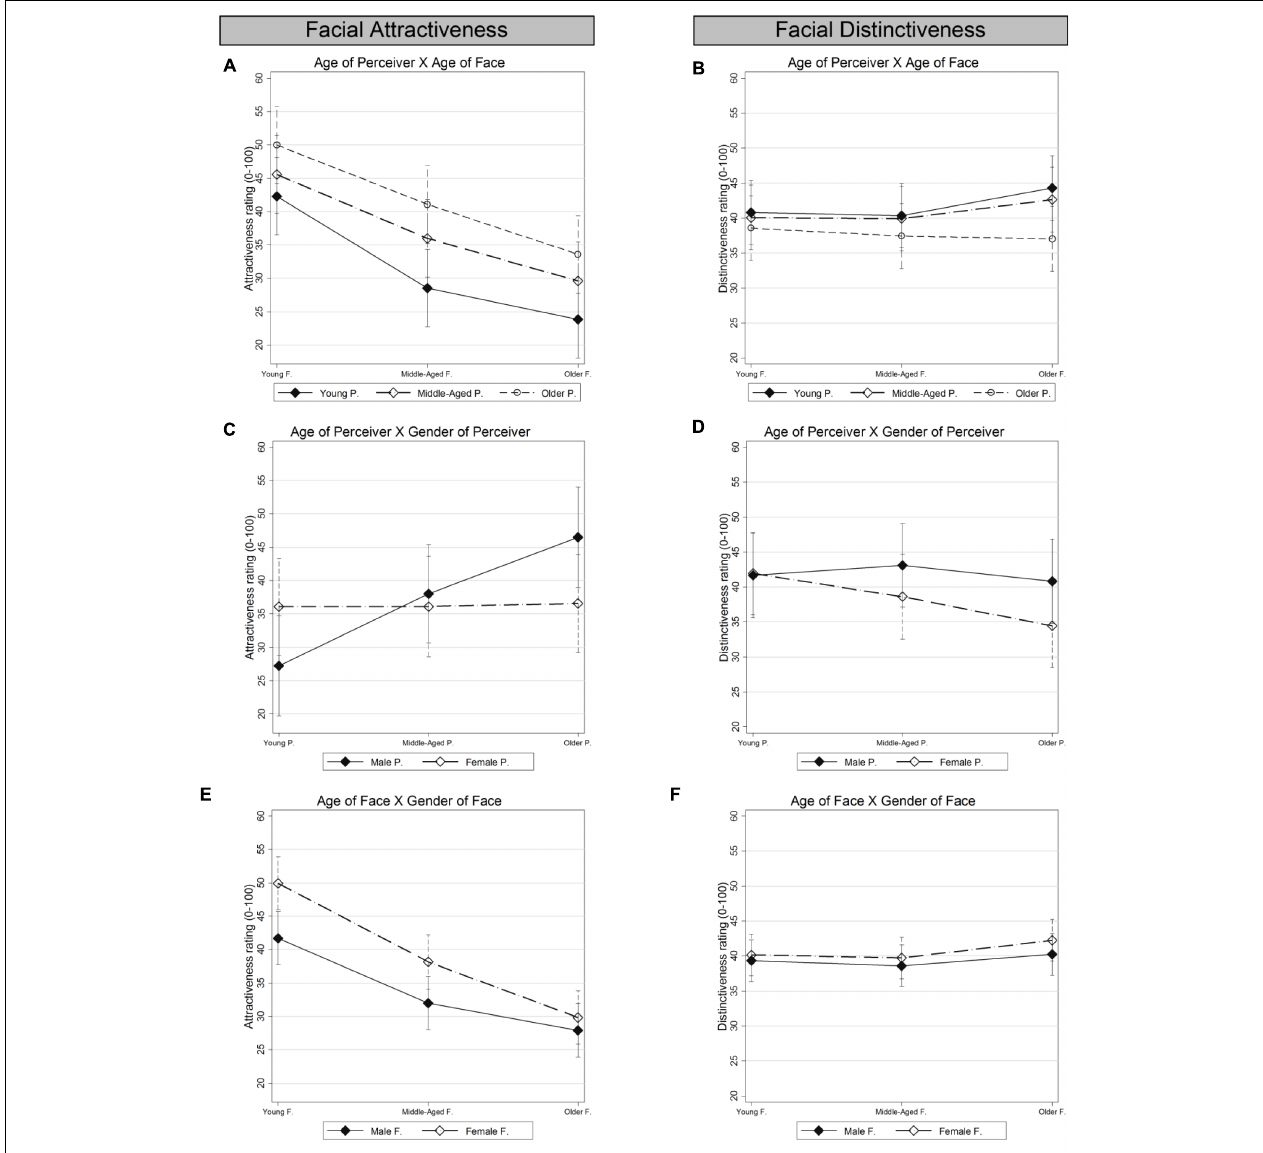
FIGURE 2 | Predicted marginal means for attractiveness and distinctiveness for specified two-way interactions pertaining to age and gender: (A) Age of Perceiver × Age of Face, for attractiveness. (B) Age of Perceiver × Age of Face, for distinctiveness. (C) Age of Perceiver × Gender of Perceiver, for attractiveness. (D) Age of Perceiver × Gender of Perceiver, for distinctiveness. (E) Age of Face × Gender of Face, for attractiveness. (F) Age of Face × Gender of Face, for distinctiveness. Error bars indicate 95% confidence intervals for the point predictions, corrected for multiple comparisons (Bonferroni). P = Perceiver; F = Faces.